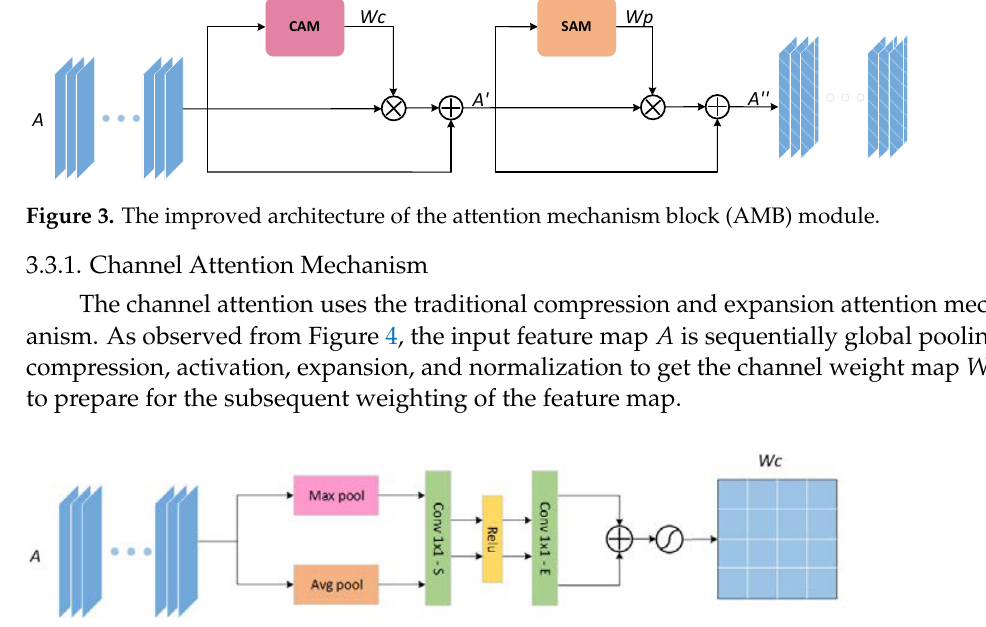
Figure 3. The i mproved architecture of the attention mechanism block (AMB) module. Figure 5. Improved channel attention mechanism (CAM) module architecture to obtain. Spatial attention weight map.